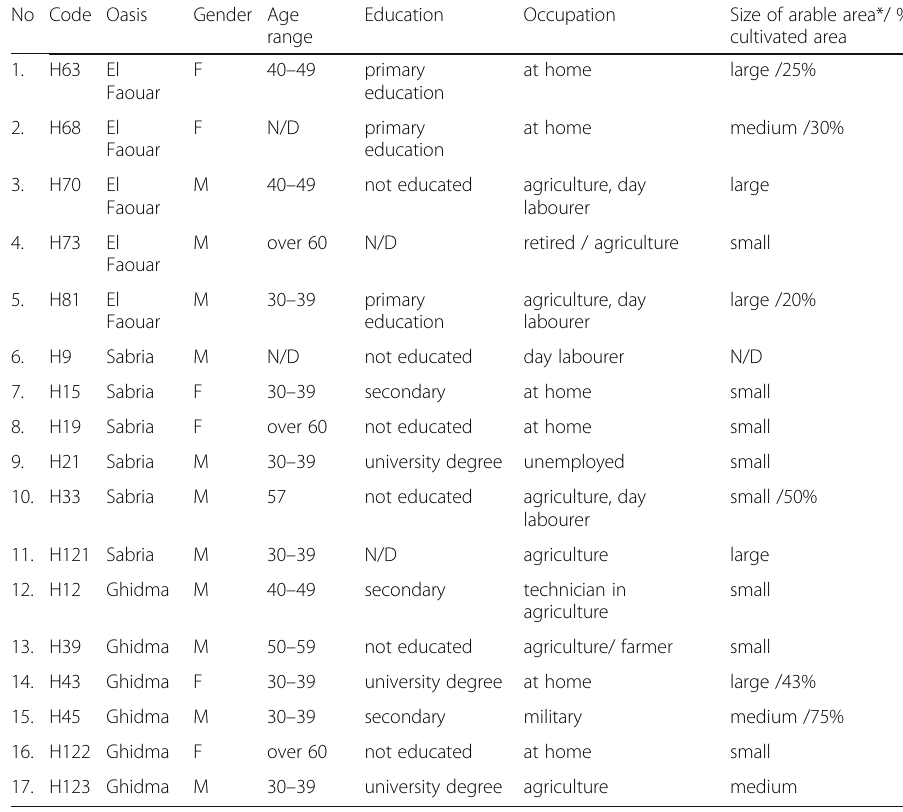
Table 1 Characteristics of in-depth interview respondents and their households No Code